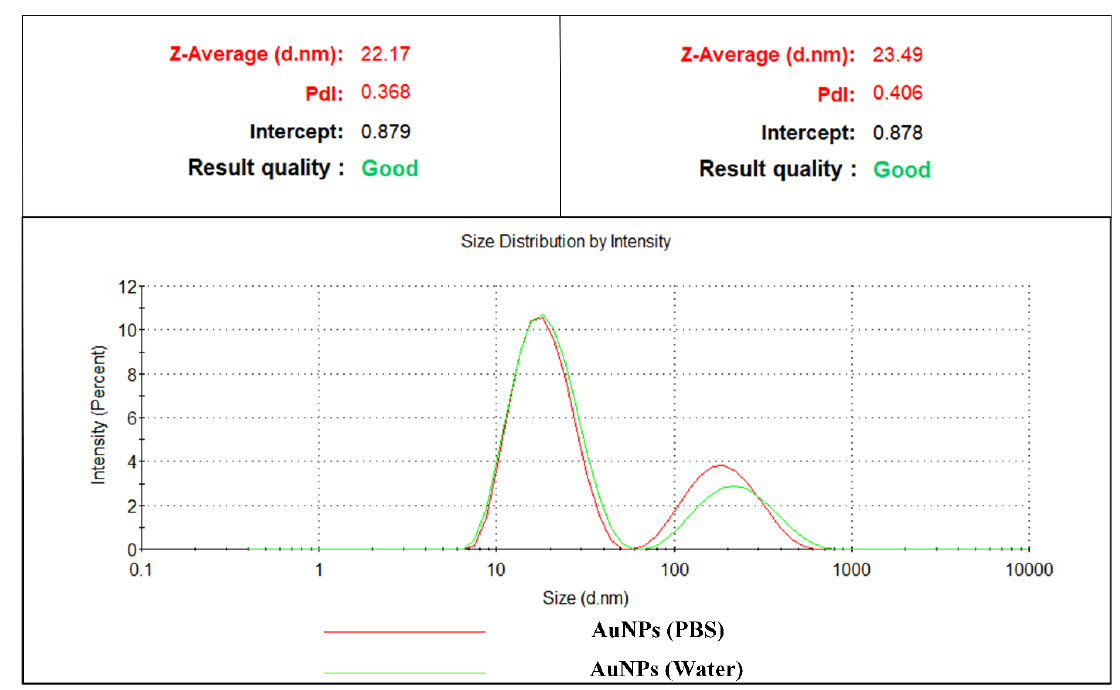
Figure 5. Polydispersity index (PDI) and hydrodynamic size of AuNPs prepared through sonochemical method. AuNPs dissolved in water (green solid line) and dissolved in PBS (red solid line).